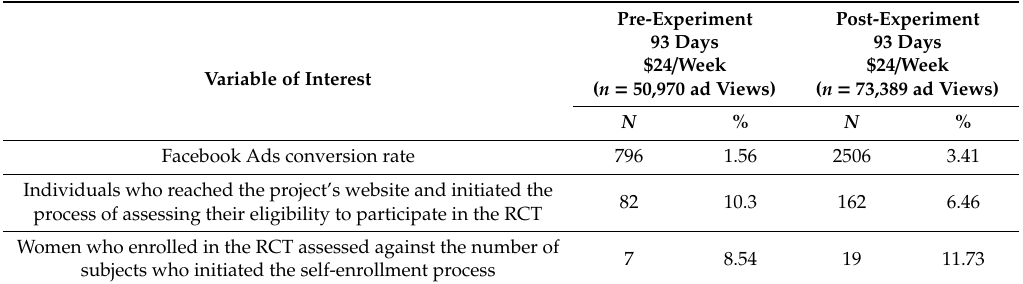
Table 2. Results of the online quasi-experiment (pre-post assessments using aggregate Facebook ads and Google Analytics